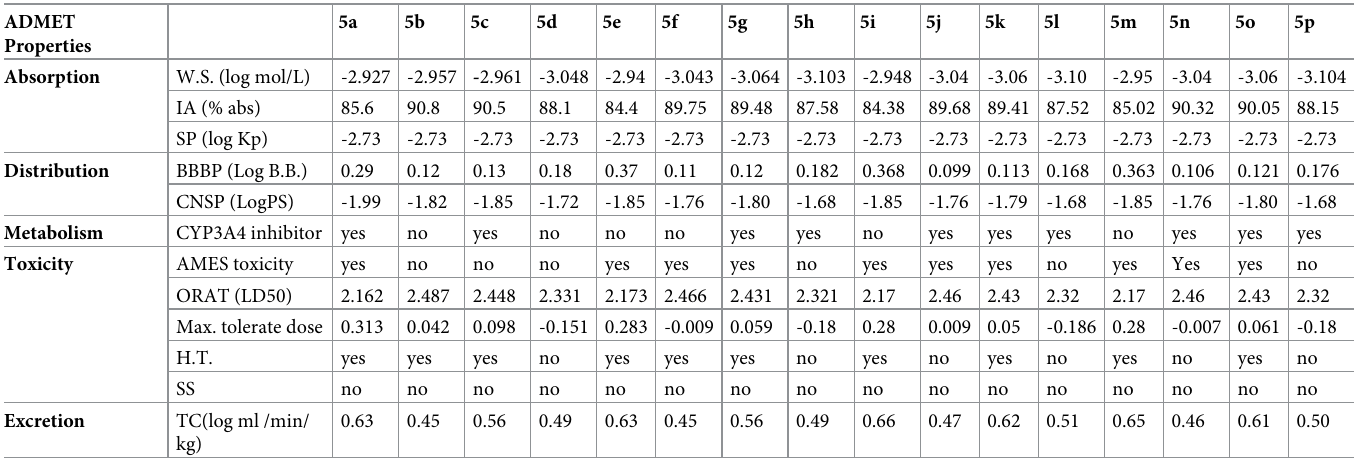
Table 2. Pharmacokinetic assessment of fuberidazole derivatives (5a-5p). ADMET